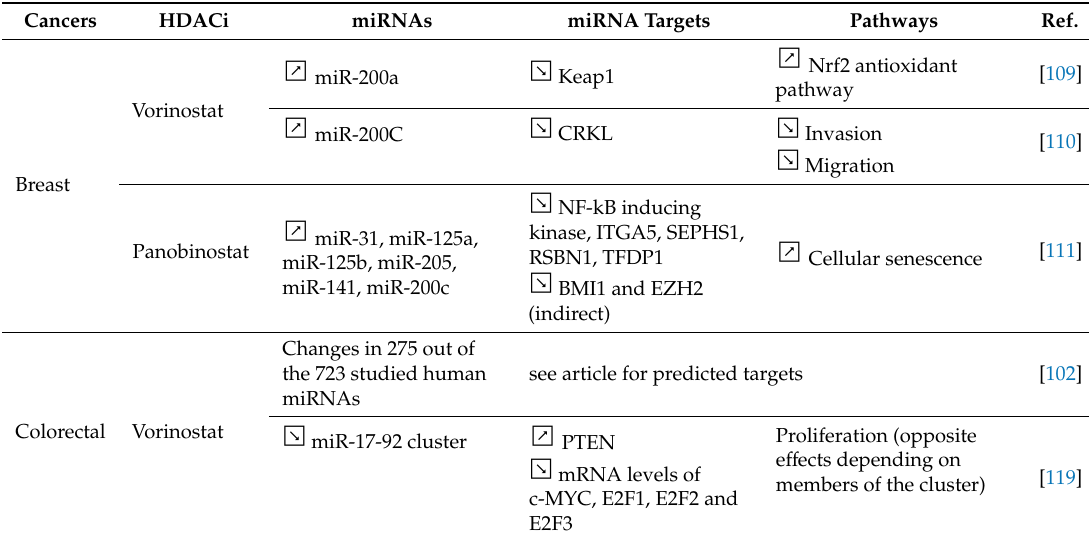
Vorinostat Panobinostat